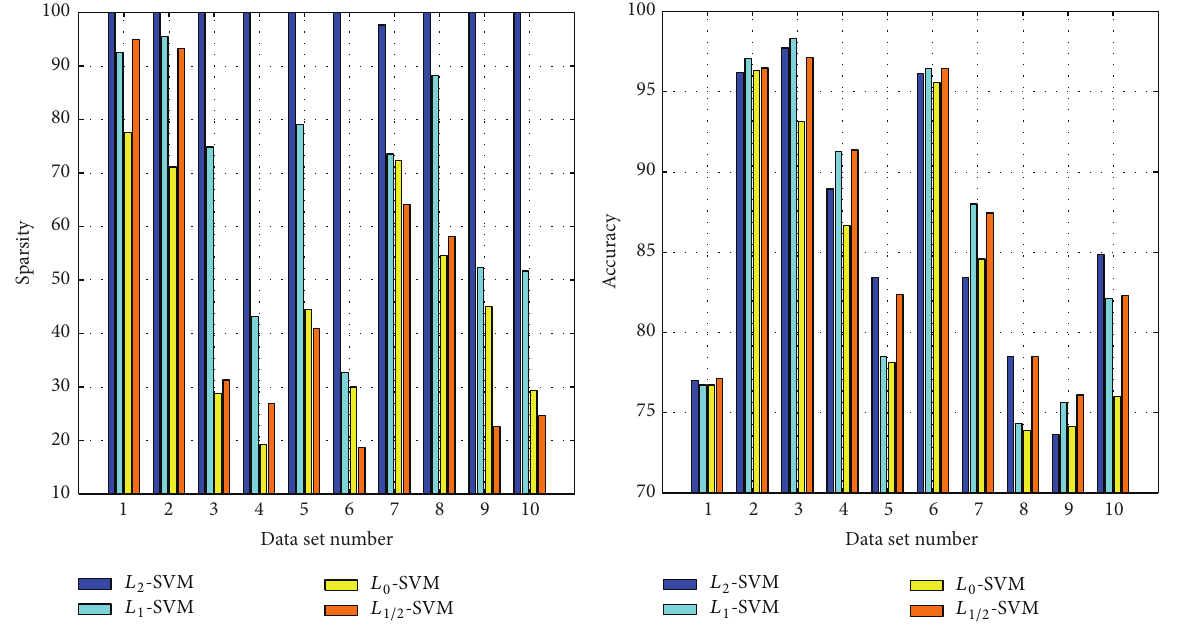
Figure 4: Results comparison on UCI data